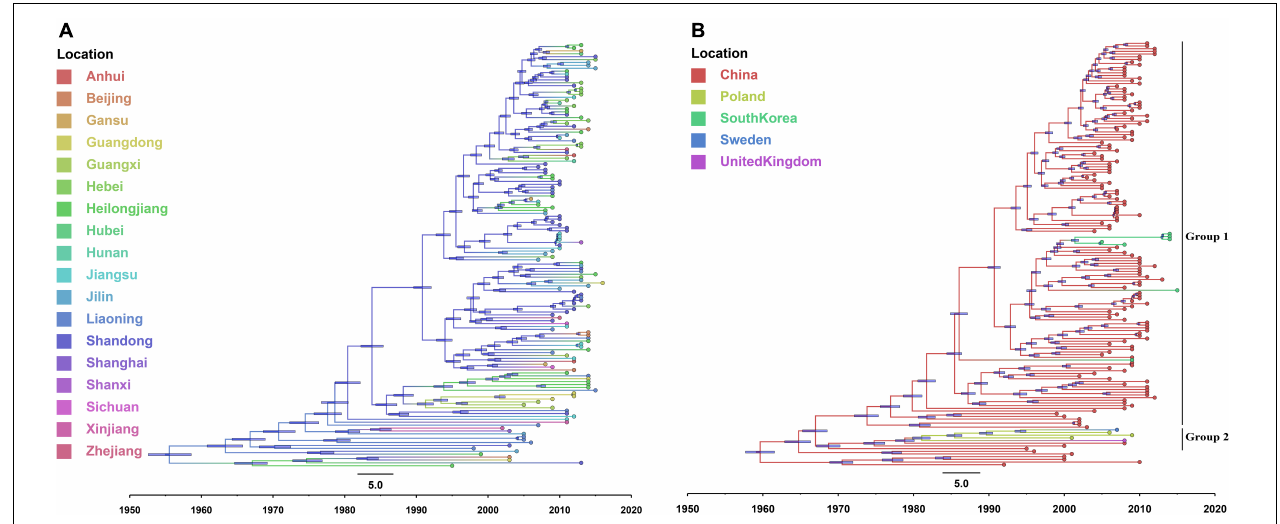
FIGURE 5 | The maximum clade credibility tree of LX4-type full-length genome sequences of infectious bronchitis virus (IBV) isolates in China (A) and the world (B) . The color of the branches corresponds to geographical